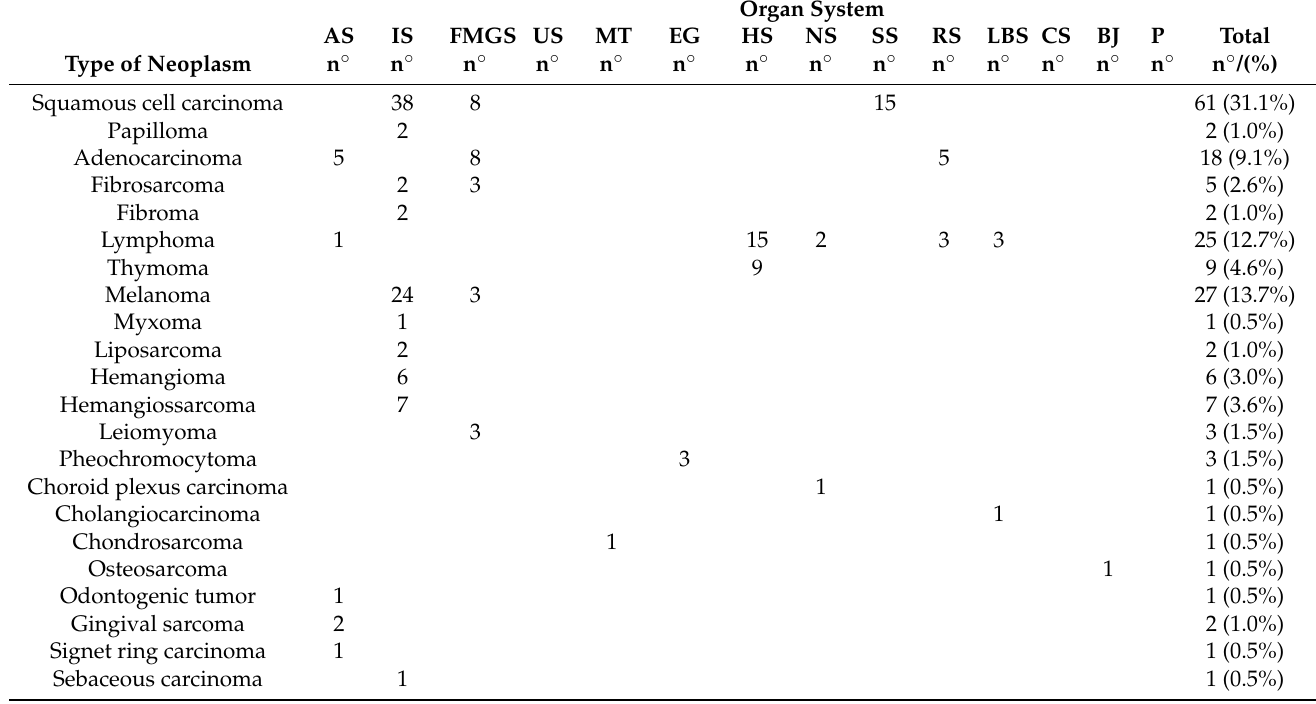
Table 5. Distribution of neoplasms in goats according to the organ